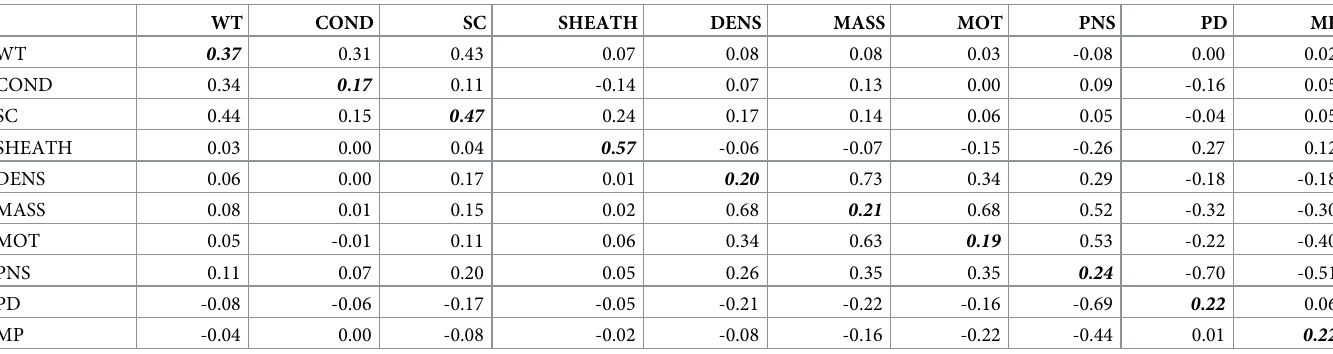
A total of 45 bi-variate analyses were performed one for as many pair-wise trait combinations and each using the across-breed GRM. Heritabilities are the average across the 9 bi-variates in which a trait was